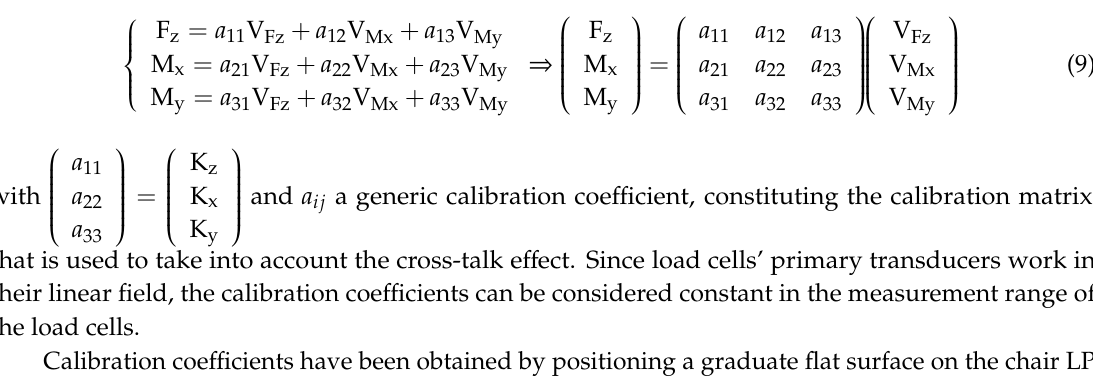
Figure 3. Load cells housing adaptors: ( a ) open adaptors; ( b ) closed adaptor with enclosed load cell: the central cylindrical element is in contact with the load-sensitive part of the load cell.